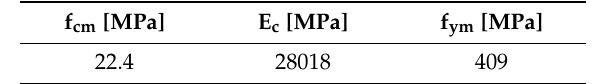
Figure 1. Pilotis RC frame ( a ) plan, ( b ) A-A view, and ( c ) B-B view. Dimensions in m. Table 1. Material properties for RC frame.